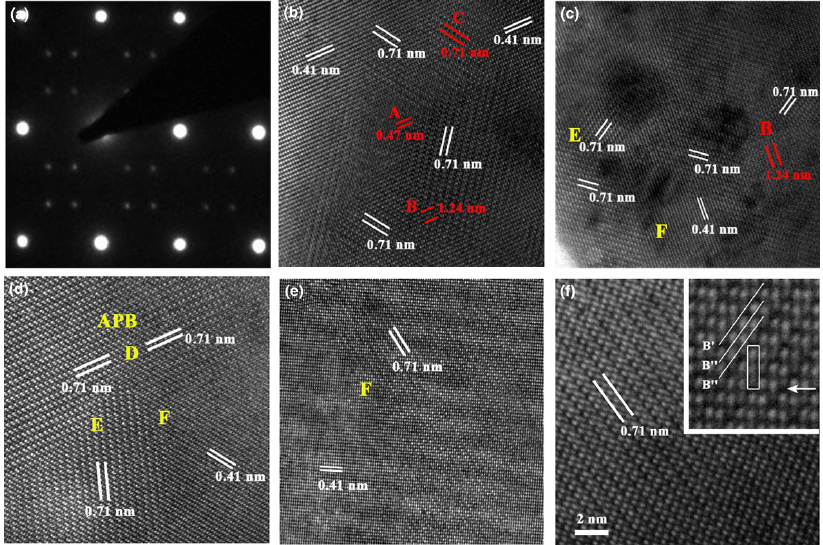
Fig. 23 SAED pattern with zone a x is [1¯10] c and the corresponding HRTEM images for Ba((Co 0.6 − x /2 Zn 0.4 − x /2 Mg x ) 1/3 Nb 2/3 )O 3 ceramics: (a) x = 0.1; (b) x = 0; (c) x = 0.1; (d) x = 0.2; (e) x = 0.3; (f) HRTEM image of an ordered area in high magnification. Reproduced with permission from Ref. [511], © The American Ceramic Society